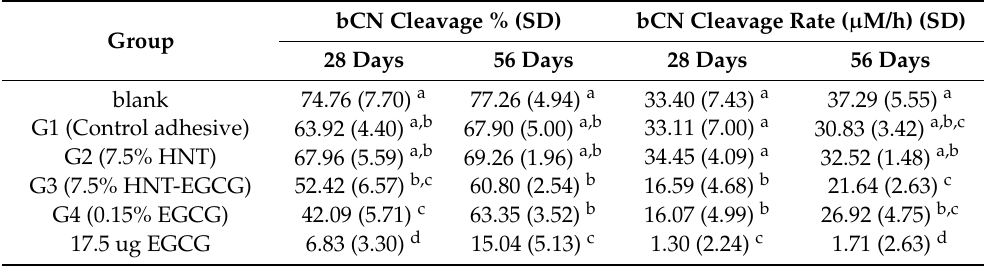
Table 3. bCN cleavage by MMP-9 (% relative to the baseline) and the cleavage rate ( µ M/h) results.